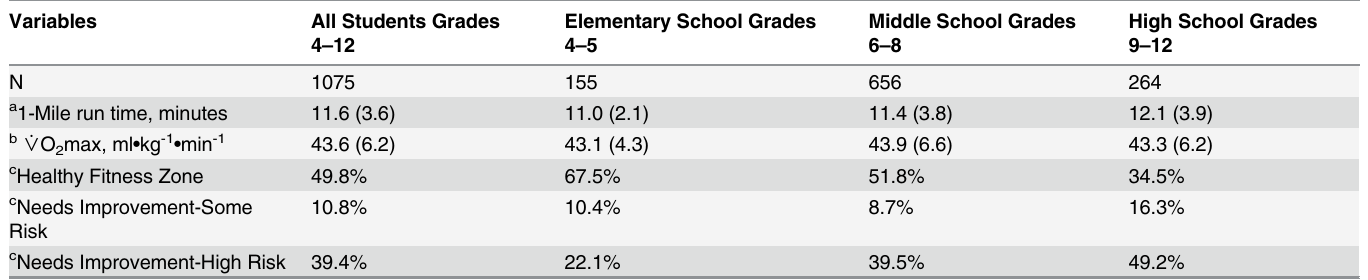
Table 2. Aerobic Fitness and FITNESSGRAM Classification of Urban School Students by Grade Level, Age (cid:1) 9.0 years.